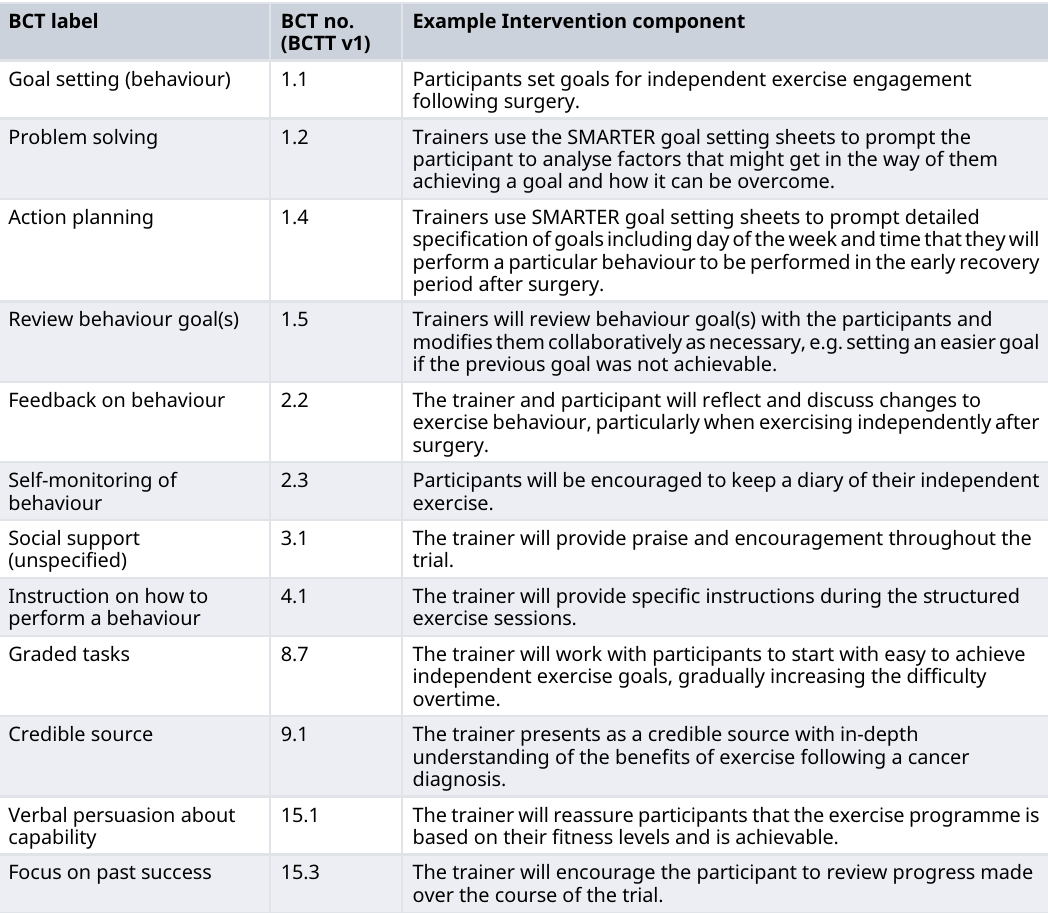
Table 1. Behaviour change techniques (BCT) coded to the BCT taxonomy (BCTT V1). BCT